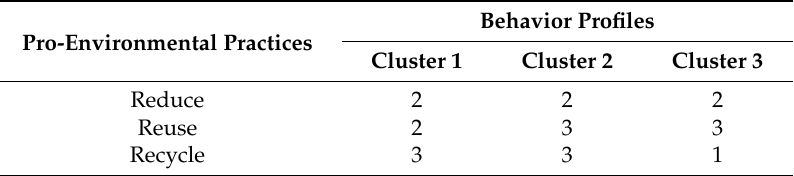
Table 7. Consumers’ environmental practices as related to types of behavior.